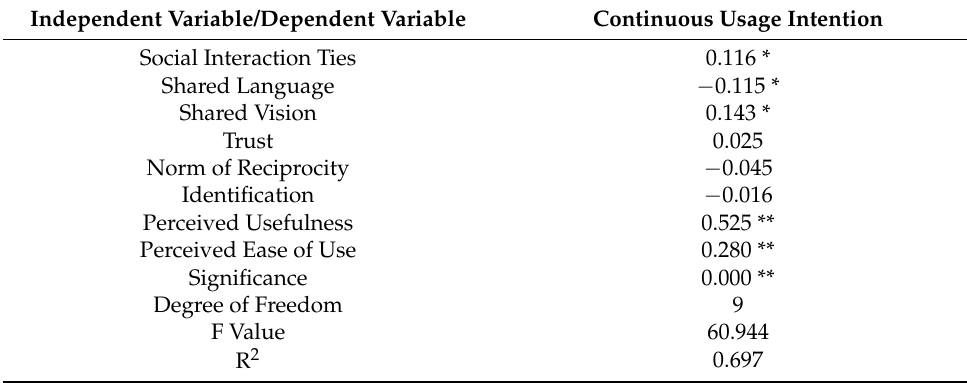
Table 8. The results of regression